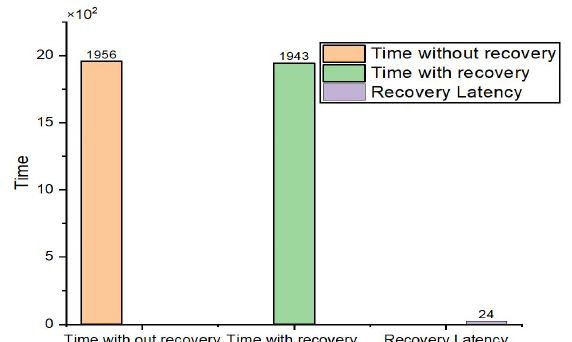
Figure 8. Results of performance (time): Pattern A.